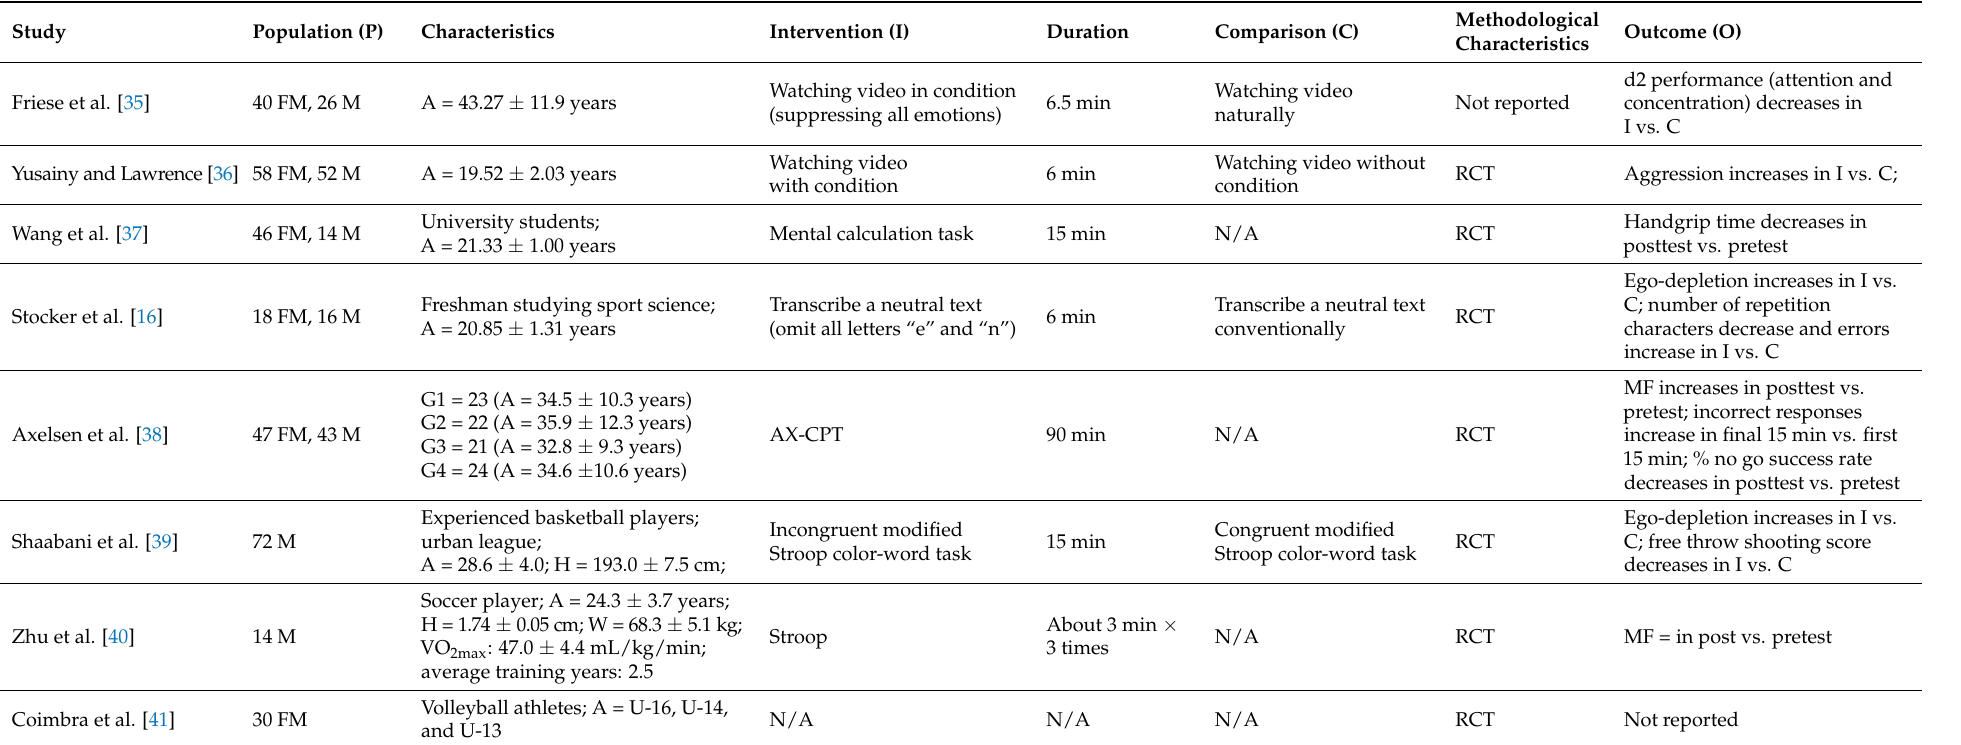
Table 4. Overview of mental-fatigue inducing